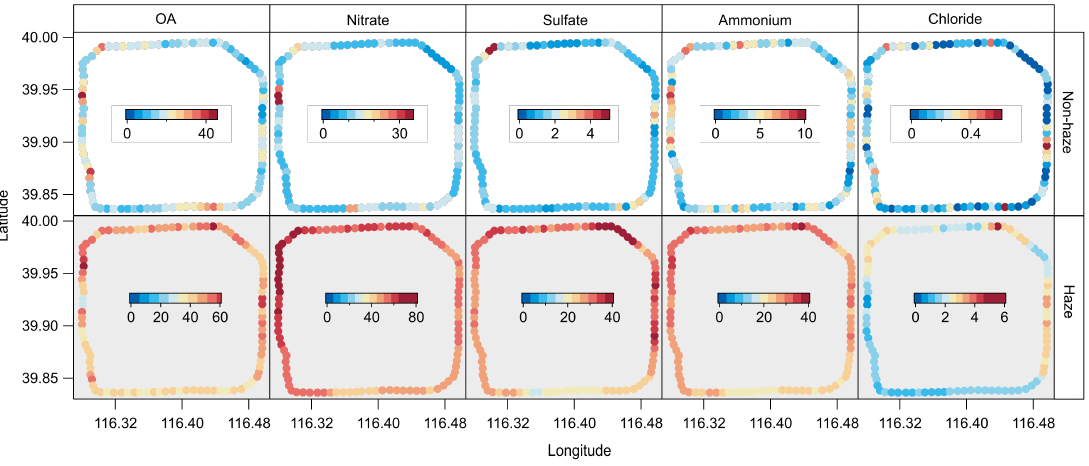
Figure 3. Spatial patterns of the mean mass concentrations (units: µgm − 3 ) of the key PM 2 . 5 chemical components measured on the 4th Ring Road in Beijing. Data covered from 09:00 to 16:00 during the measurement